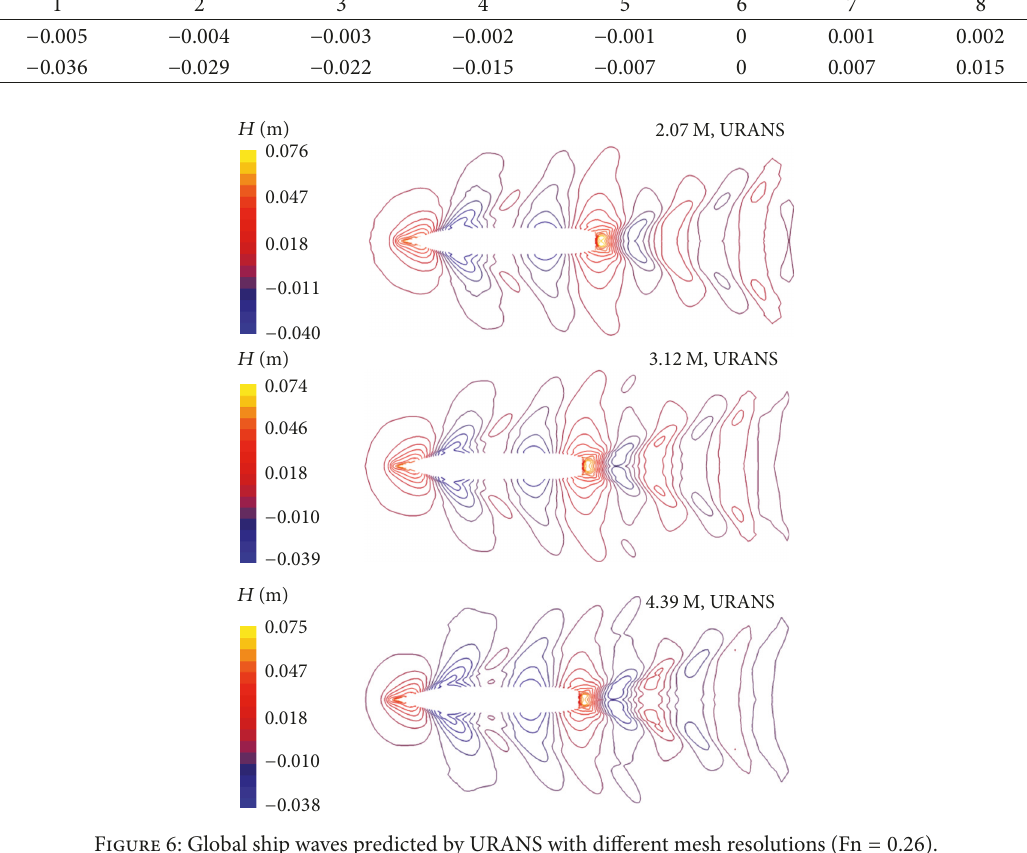
and the velocities within the boundary-layer are difficult to predict accurately, especially for the flow around a